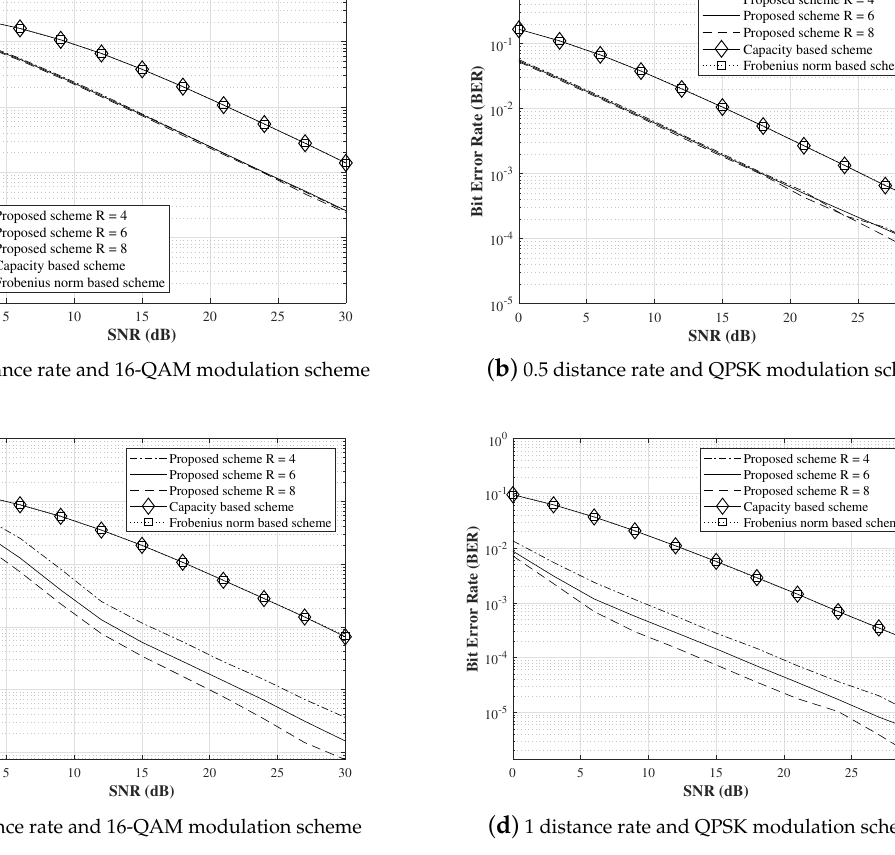
Figure 4. BER performance with 8